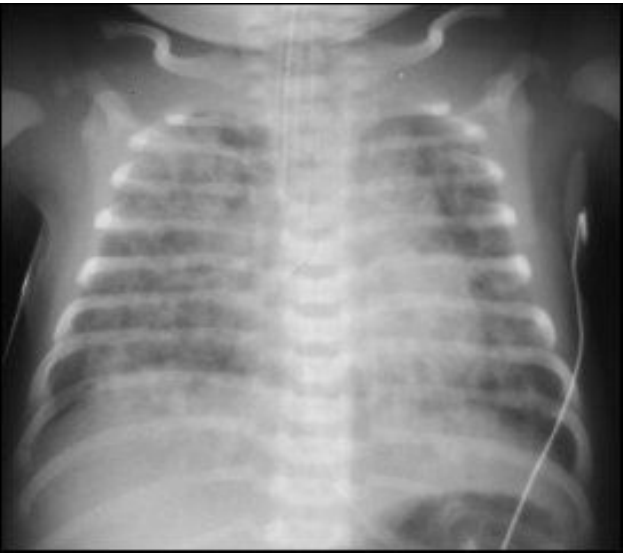
Figure 2. Chest radiograph demonstrating diffuse patchy opacification of the lungs, an example from an infant with meconium